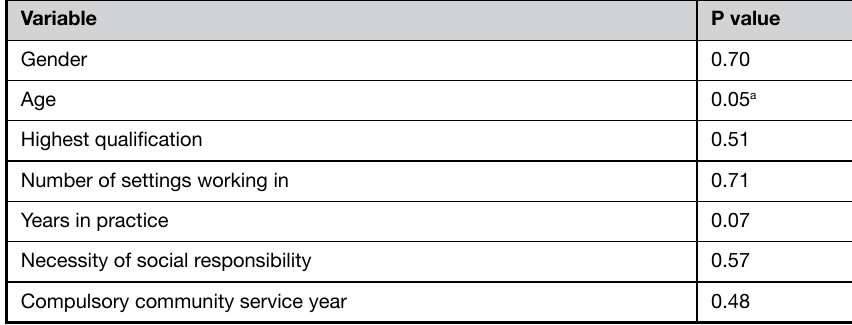
Table 4: univariate Predictors of Agreement with the indicators of Social